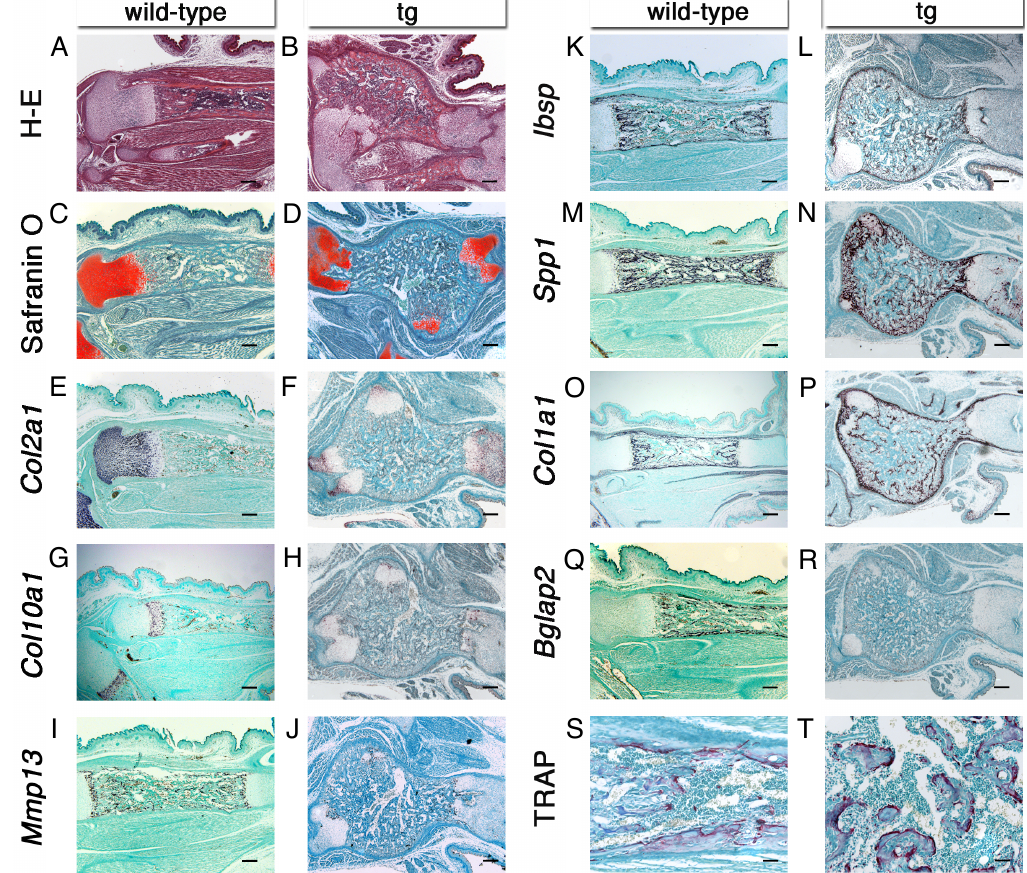
Figure 4. Histological analyses of tibiae in Hck CA tg embryos at E18.5. ( A and B ) H-E staining in wild-type ( A ) and Hck CA tg ( B ) embryos. ( C and D ) Safranin O staining in wild-type ( C ) and Hck CA tg ( D ) embryos. ( E – R ) In situ hybridization using Col2a1 ( E , F ), Col10a1 ( G , H ), Mmp13 ( I , J ), Ibsp ( K , L ), Spp1 ( M , N ), Col1a1 ( O , P ), and Bglap2 ( Q , R ) probes in wild-type ( A , C , E , G , J , K , M , O , Q ) and Hck CA tg ( B , D , F , H , J , L , N , P , R ) embryos. ( S and T ) TRAP staining in wild-type ( S ) and Hck CA tg ( T ) embryos. Scale bars: 200 µ